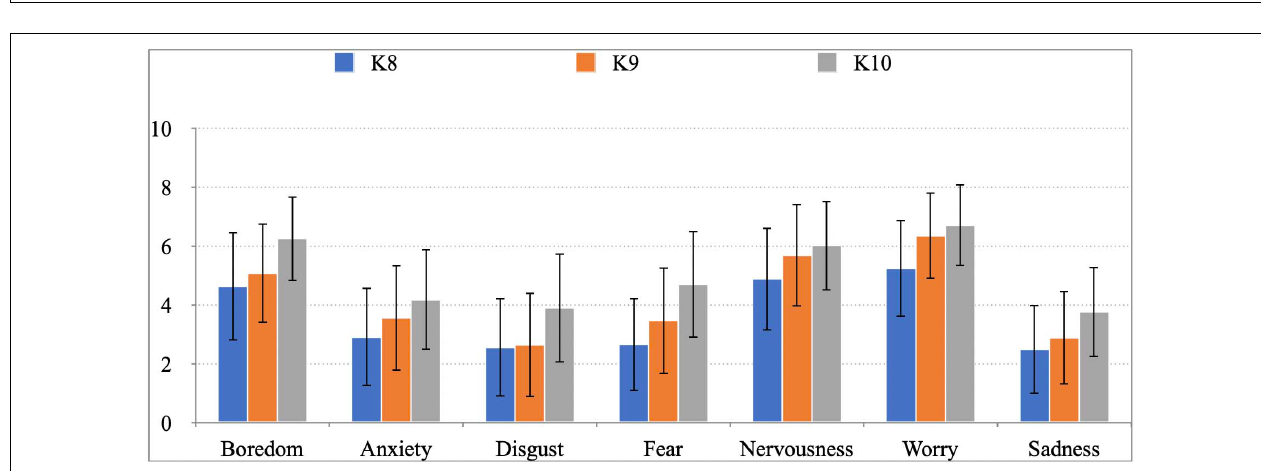
FIGURE 1 | Mean frequency of positive emotions experienced by secondary pupils when learning Physics and Chemistry depending on the course.